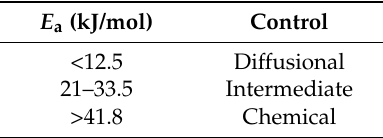
Table 4. Control according to the E a value.